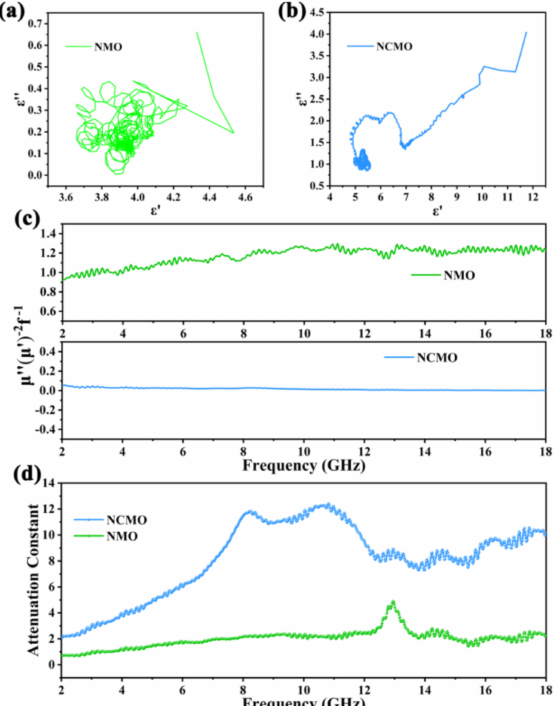
Figure 6. ( a ) Cole–Cole plots of NMO; ( b ) Cole–Cole plots of NCMO; ( c ) C0 values of NMO and NCMO; ( d ) Attenuation constants ( α ) of NMO and NCMO.